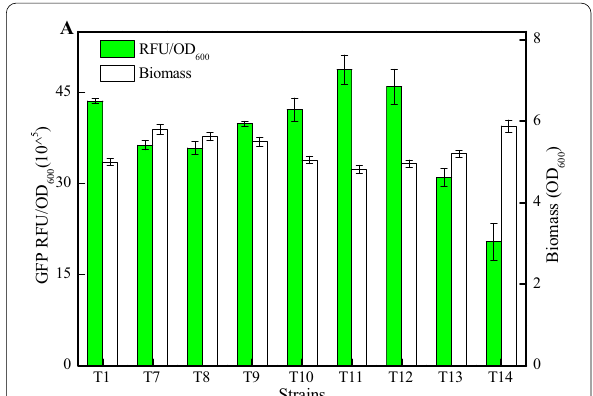
Fig. 2 Effect of distance between stop codon and terminator on intrinsic terminator T1. A Green fluorescence intensities and cell biomasses of recombinant strains with different terminators (T7–T14)